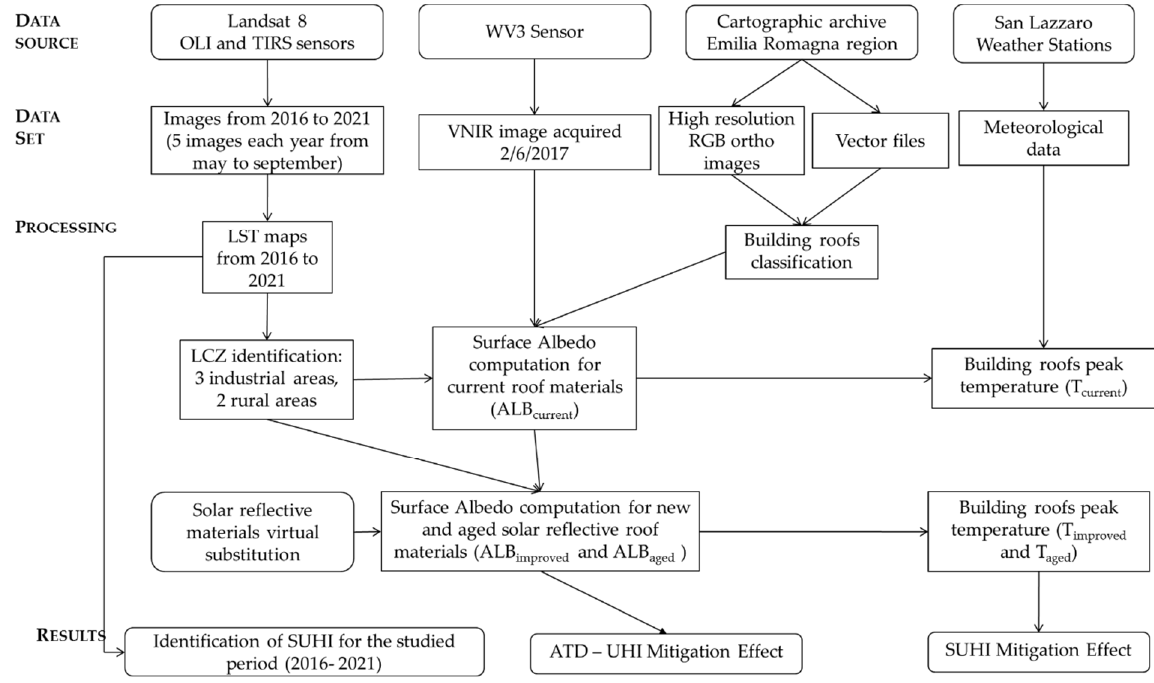
Figure 3. Flowchart of the methodology used in this